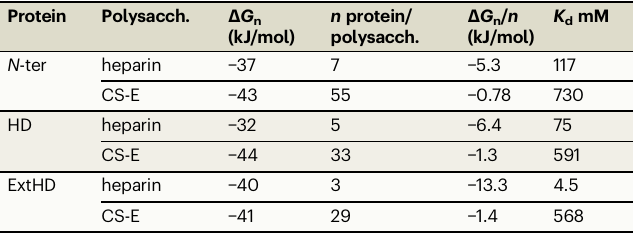
Table 3 | Interaction thermodynamics of the N -ter octadeca- peptide and proteins with heparin and CS-E, studied by ITC Protein